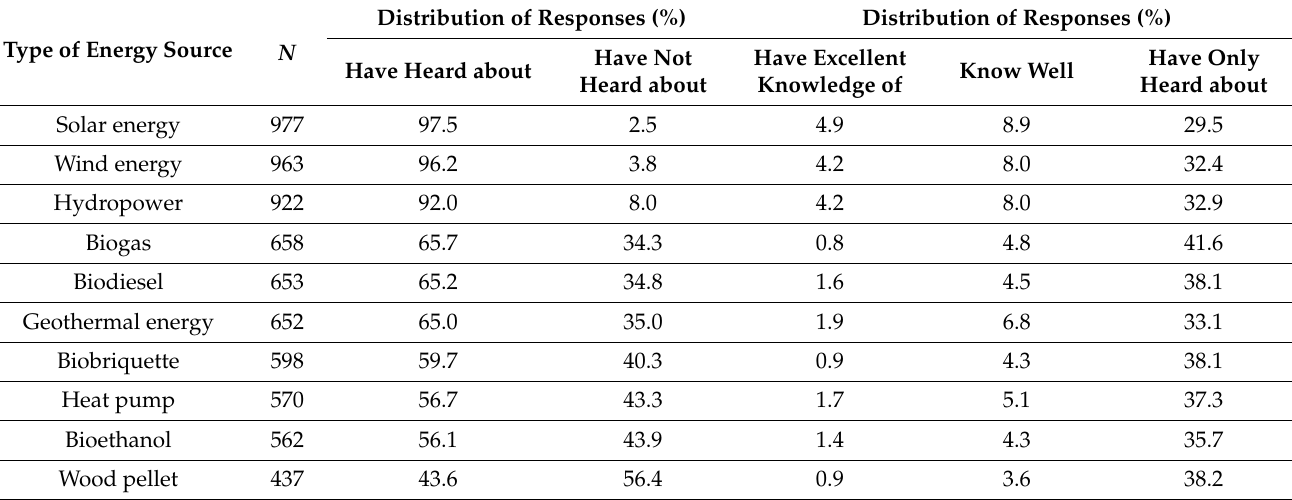
Table 3. Public awareness of different renewable energy sources and energy processes ( N = 1002). Distribution of Responses (%) Distribution of Responses (%) Type of Energy Source N Have Only Have Not Have Excellent Know Well Have Heard about Heard Heard about Knowledge of